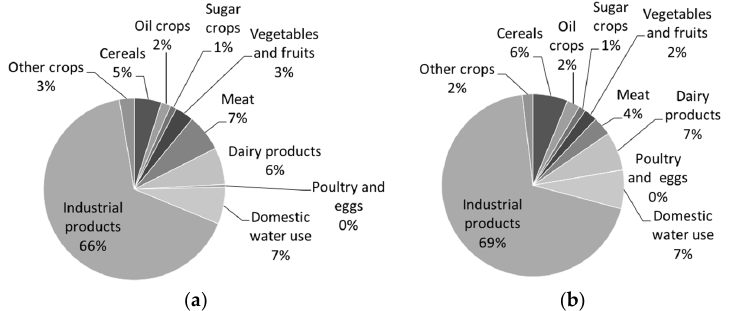
Figure 11. The composition of the grey water footprint (WF) of European consumption by commodity in scenarios ( a ) S1/S2 and ( b ) S3/S4.